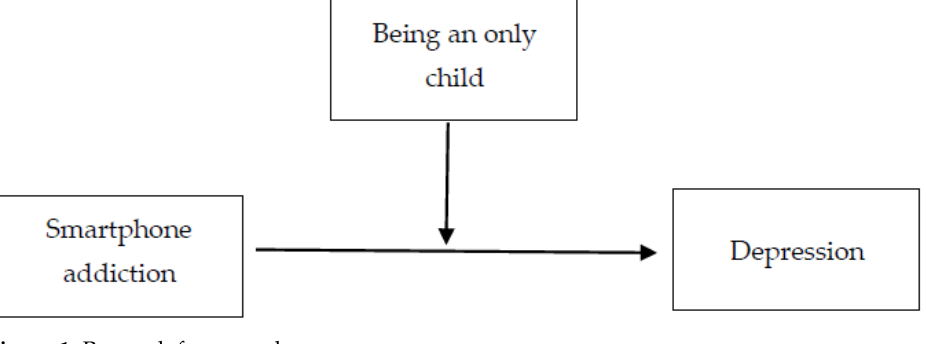
Figure 1. Research framework.